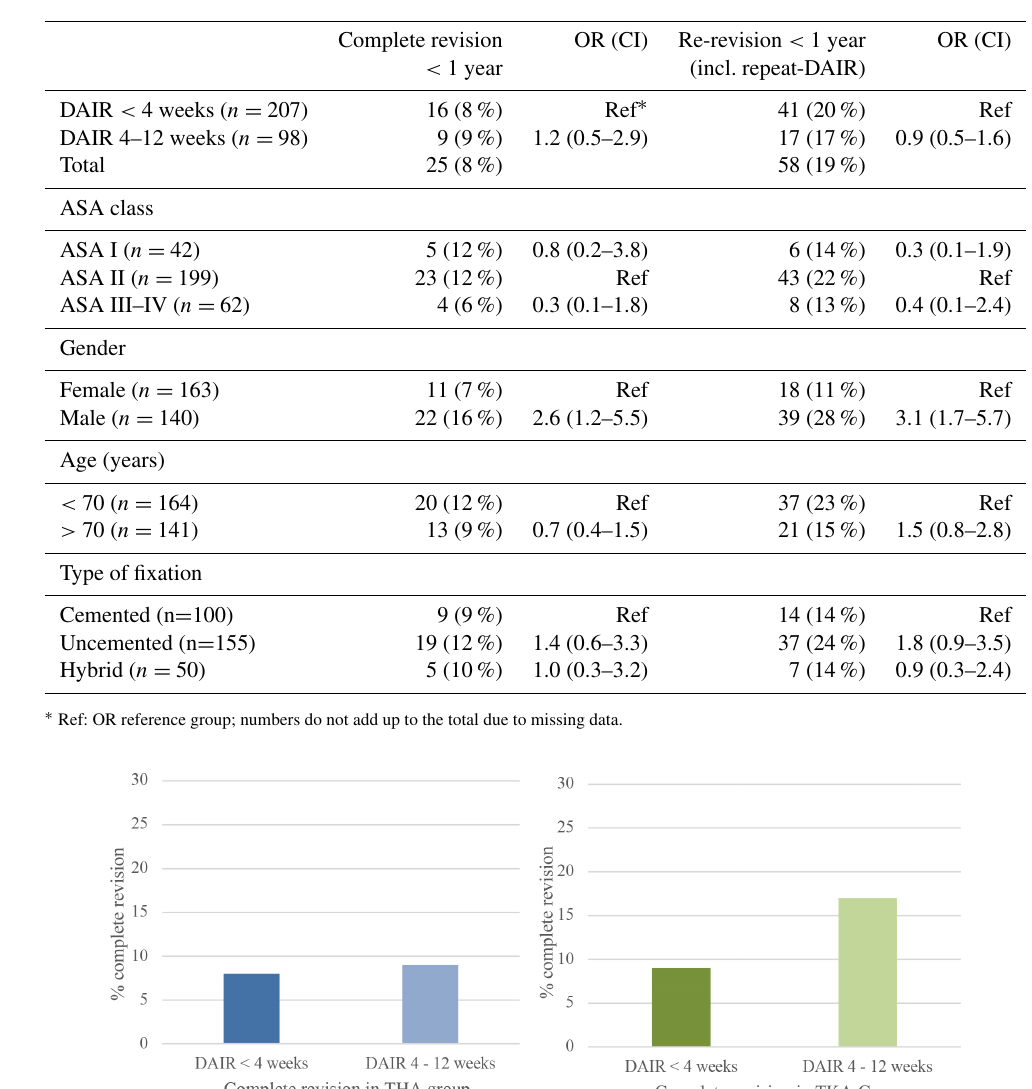
Table 2. Number of re-revisions after DAIR procedures with odd ratios for different timings of DAIR after primary THA.